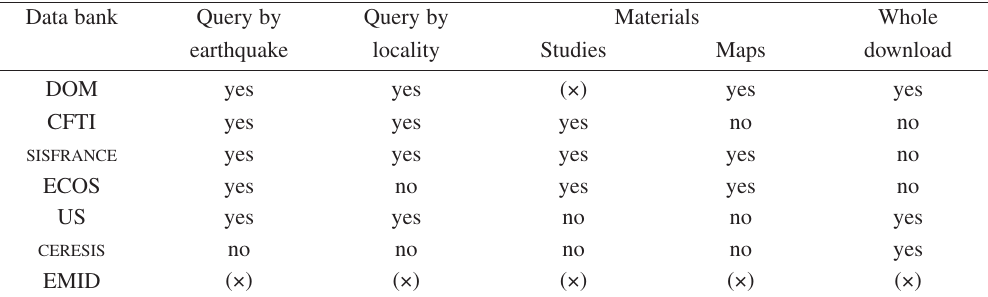
Table II. Main features of the online available intensity databanks. Data